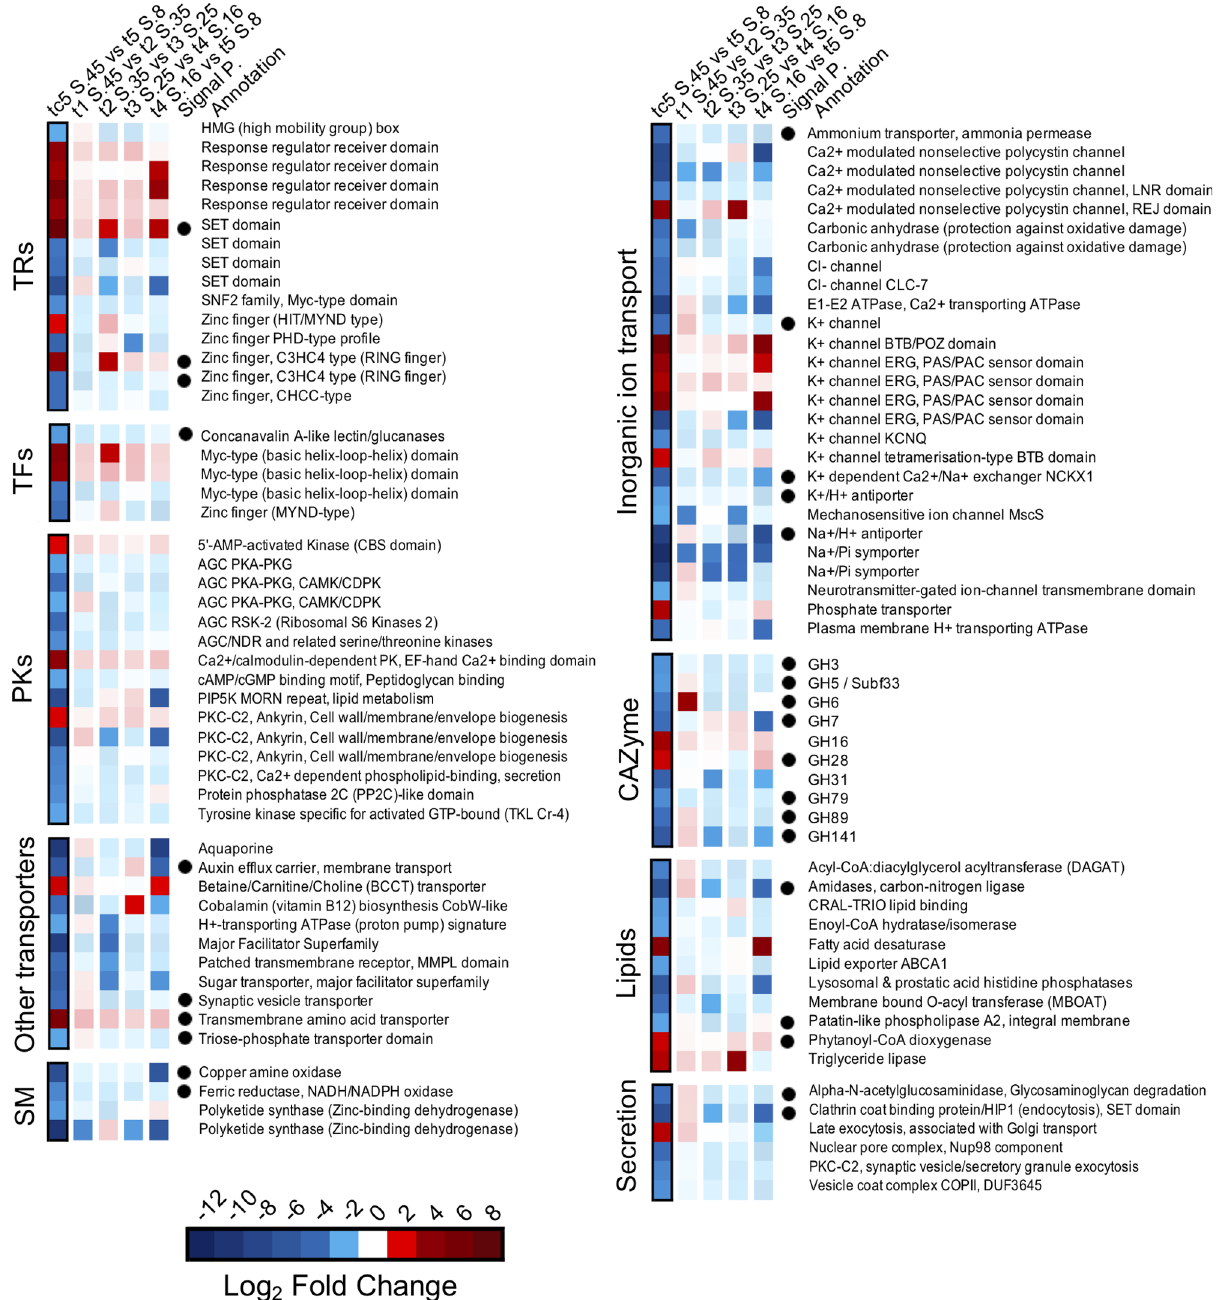
Fig. 5 Differential expression of genes involved in nine selected PFAM superfamily or PROSITE categories. The log 2 fold change for each comparison of salinity (see Figs. 3 and 4) are indicated by the blue and red colors. The intensity of overexpression between the salinity comparisons follows the convention that reds indicate greater expression at the higher salinity, and blues indicate greater expression at the lower salinity of the comparison. The fi rst column compares S.45 to S.8. and red indicates overexpression at S.45 and blue indicates overexpression at S.8. The presence of a signal peptide (P.) is indicated with a black circle. TRs transcription regulators, TFs transcription factors, PKs protein kinases, SM secondary metabolites, CAZYmes carbohydrate-active enzymes. CAZYmes glycoside hydrolase (GHs) details are given in Supplementary Table